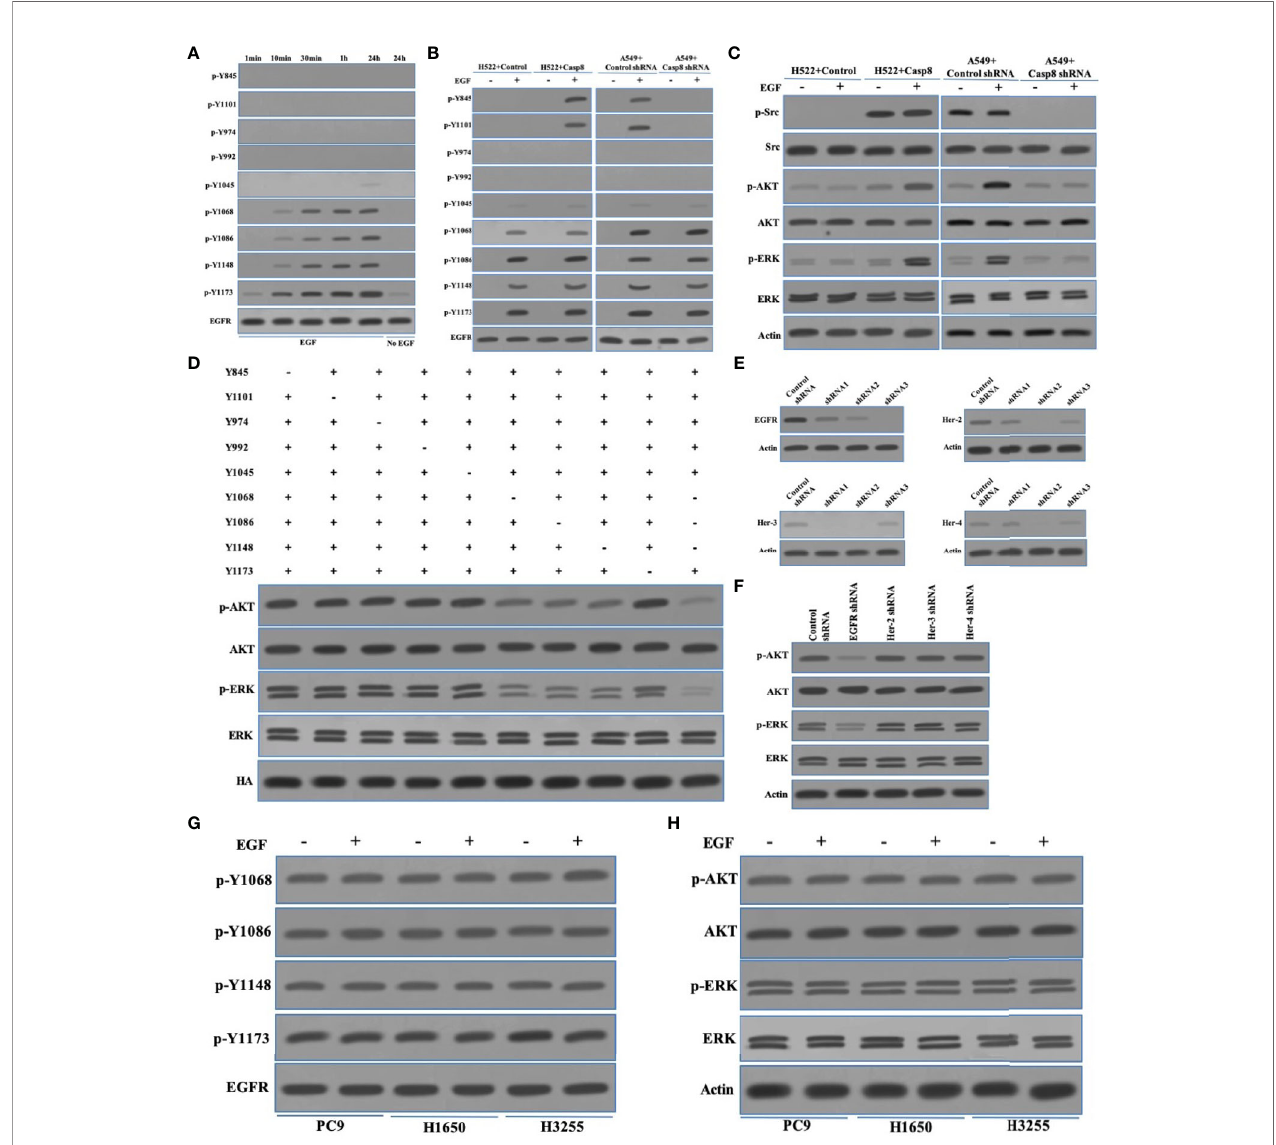
FIGURE 4 | c-Src was unable to trigger EGFR-related signaling re fl ected by the phosphotyrosines 1068, 1086, and 1145 of EGFR. (A) Immunoblotting analysis of p-Y845, p-Y1101, p-Y947, p-Y992, p-Y1045, p-Y1068, p-Y1086, p-Y1148, p-Y1173 of EGFR and EGFR in H522 cells with Casp8 WT attached on fi bronectin for 24 h stimulated by EGF or not as indicated times. (B) Immunoblotting analysis of p-Y845, p-Y1101, p-Y947, p-Y992, p-Y1045, p-Y1068, p-Y1086, p-Y1148, p- Y1173 of EGFR and EGFR in H522 cells with control vector or Casp8 WT and A549 cells with control shRNA or Casp8 shRNA attached on fi bronectin for 24 h stimulated by EGF or not for 24 h. (C) Immunoblotting analysis of p-Src, c-Src, p-AKT, AKT, p-ERK, ERK and b -actin in H522 cells with control vector or Casp8 WT and A549 cells with control shRNA or Casp8 shRNA attached on fi bronectin for 24 h stimulated by EGF or not for 24 h. (D) Immunoblotting analysis of p-AKT, AKT, p-ERK, ERK and HA in EGFR-deleted A549 cells transfected with lentiviral tyrosine mutants of EGFR attached on fi bronectin for 24 h stimulated by EGF for 24 h. (E) Immunoblotting analysis of EGFR, Her-2, Her-3, Her-4 and b -actin in A549 cells with lentiviral shRNAs speci fi c for control, EGFR, Her-2, Her-3 and Her-4. (F) Immunoblotting analysis of p-AKT, AKT, p-ERK, ERK and b -actin in A549 cells with lentiviral shRNAs speci fi c for control, EGFR, Her-2, Her-3 and Her-4 attached on fi bronectin for 24 h stimulated by EGF for 24 hr. (G) Immunoblotting analysis of p-Y1068, p-Y1086, p-Y1148, p-Y1173 of EGFR and EGFR in PC9, H1650 and H3255 cells stimulated by EGF or not for 24 hr. (H) Immunoblotting analysis of p-AKT, AKT, p-ERK, ERK and b -actin in PC9, H1650 and H3255 cells attached on fi bronectin for 24 h stimulated by EGF or not for 24